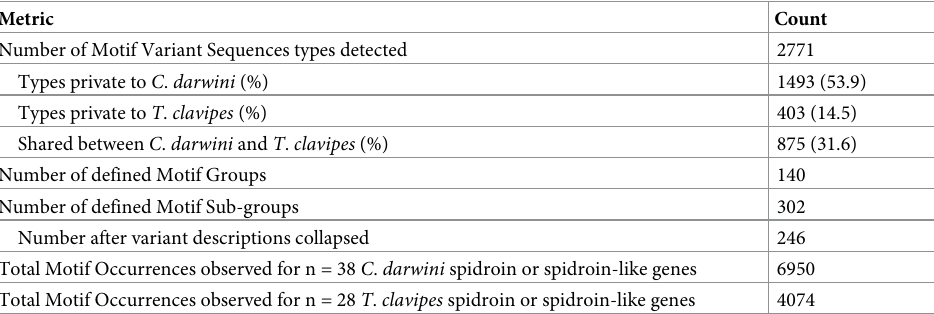
Table 2. Spidroin repeat motif summary for C . darwini and motif sharing with T . clavipes .